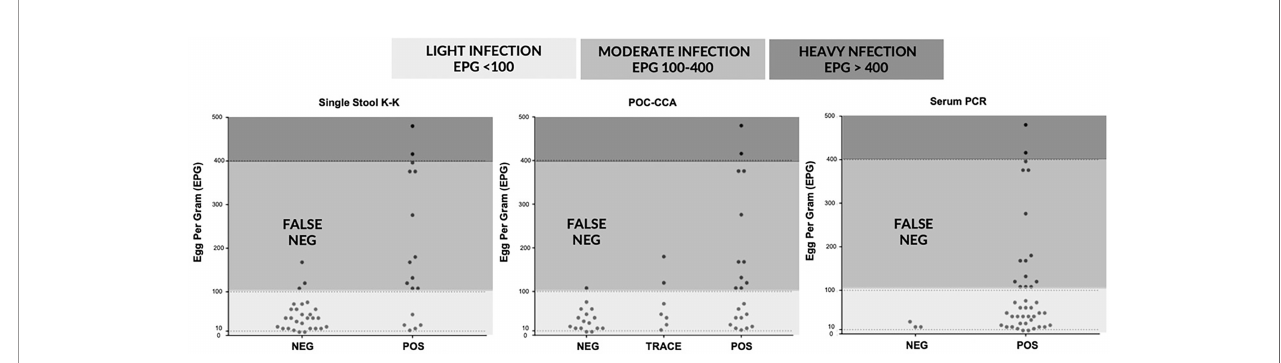
FIGURE 3 | Correlations of egg per gram (EPG) determined by three stool Kato-Katz with results of single stool Kato-Katz, point of care circulating cathodic antigen (POC-CCA) urine test, and serum PCR (n